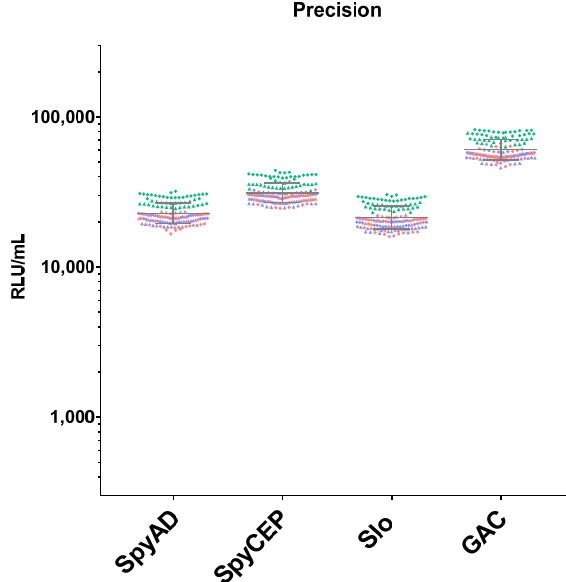
Figure 2. Assay precision . A total of 144 repeated measurements of IgG titres from a single independently handled sample, by two operators on three different days. Single repeats of each operator are represented by circle symbols (for operator 1) and triangles (for operator 2), repeats on different days are shown in orange for day 1, green for day 2 and blue for day 3. Geometric means and geometric standard deviations from 144 repeats are represented by the grey lines for each of the anti- gens. Table 2. Repeatability and intermediate precision calculation. No significant contribution to the variance component was observed by day, operator nor the interaction between day and operator. Antigen